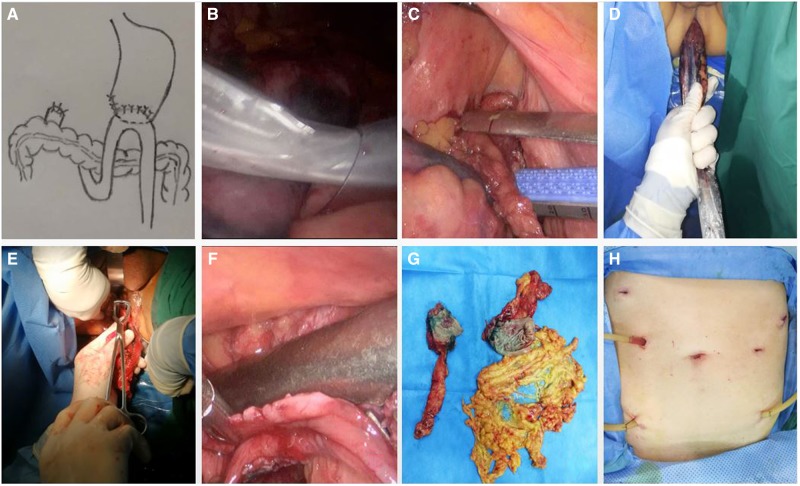
Key steps in the surgical procedure. (A) Sketch map of Billroth II gastrojejunostomy (v. Eiselsberg method); (B) a sterilized plastic protective sheath was put into the abdominal cavity through a 12-mm trocar; (C) the distal rectum was transected 3 cm below the tumor; (D) the specimen of gastric cancer was extracted through the transanal route; (E) the proximal rectum was transected with purse-string forceps and knife; (F) the rectal opening was reclosed; (G) specimens of gastric cancer, the omentum and rectal cancer; (H) only seven holes in the abdominal wall after the surgery.